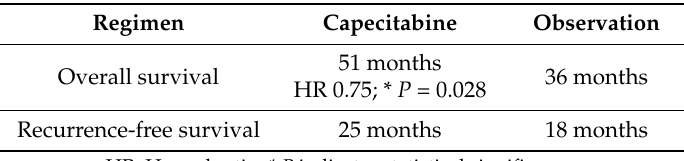
Table 9. Results of a phase III clinical trial to investigate adjuvant capecitabine in resected (R0) biliary tract carcinoma.